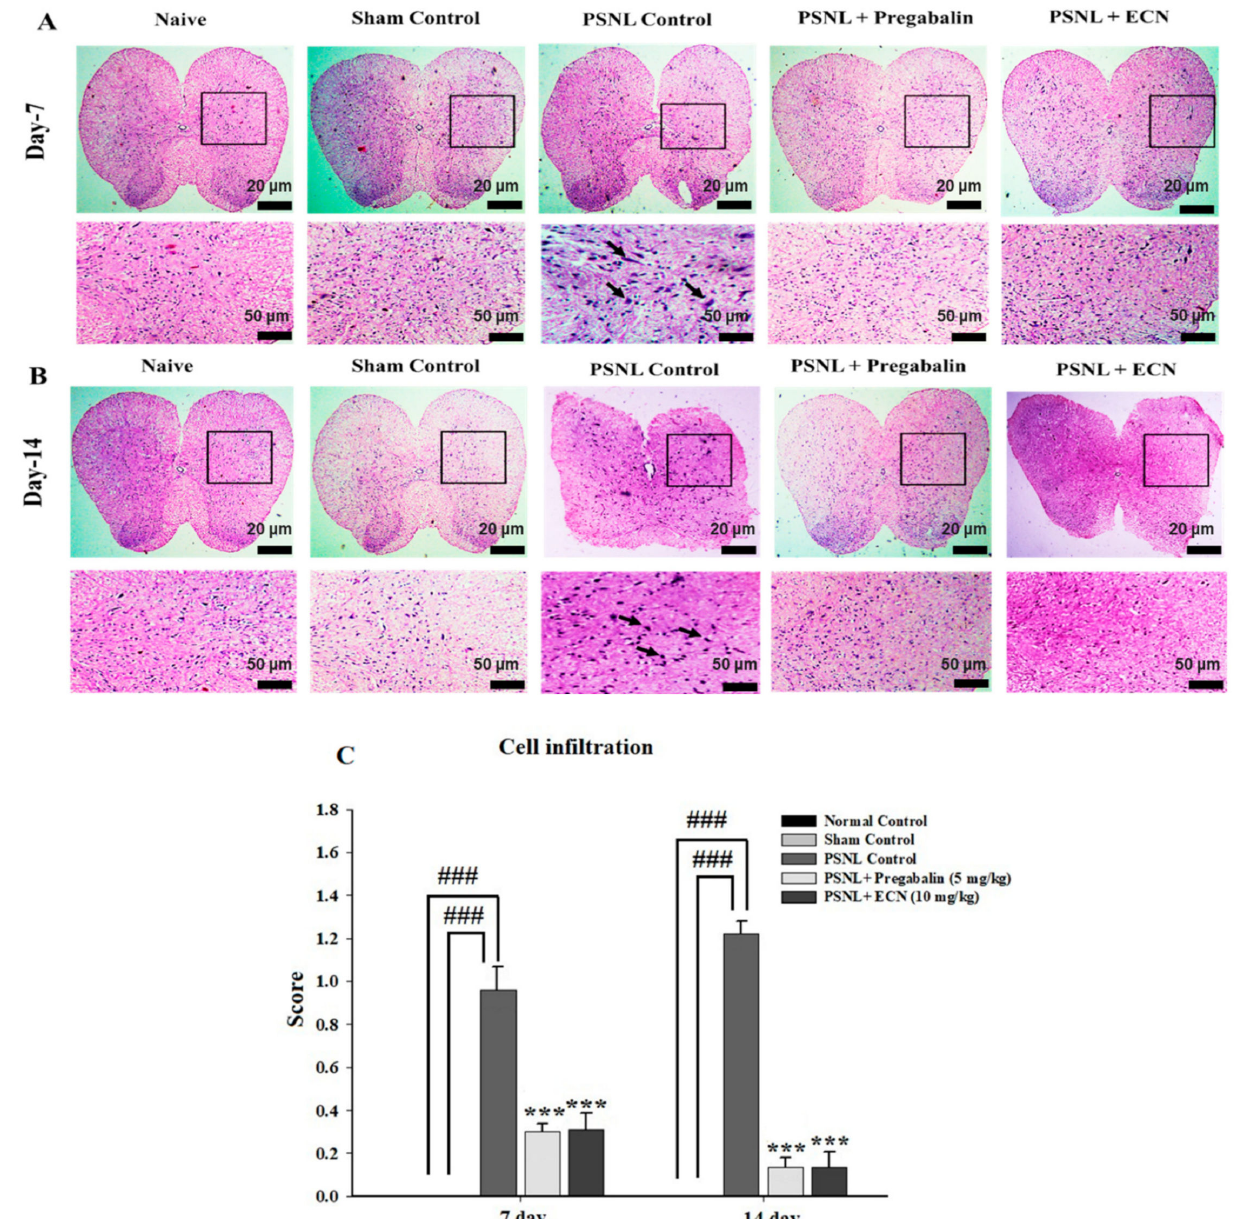
Figure 6. Effect of ECN (10 mg/kg) on the pathological histology of lumbar spinal cord tissue, the lumbar spinal cord of mice subjected to PSNL is shown in transverse sections stained with hematoxylin and eosin at 4 × & 10 × magnification (scale bar 20 µ m or 50 µ m). ( A ) Pathological histology of lumbar spinal cord tissue on day 7 post-PSNL surgery. ( B ) Pathological histology of lumbar spinal cord tissue on day 14 post-PSNL surgery. ( C ) Cell infiltration on 7 and 14-day post-PSNL surgery. The data is presented as the mean (n = 3) ± S.D. Different letters meant statistically significant differences: (***) p < 0.001 indicate significant differences from the PSNL control group. (###) indicate significant differences from the normal control group. *** p < 0.001 (two-way ANOVA followed by Dunnett’s